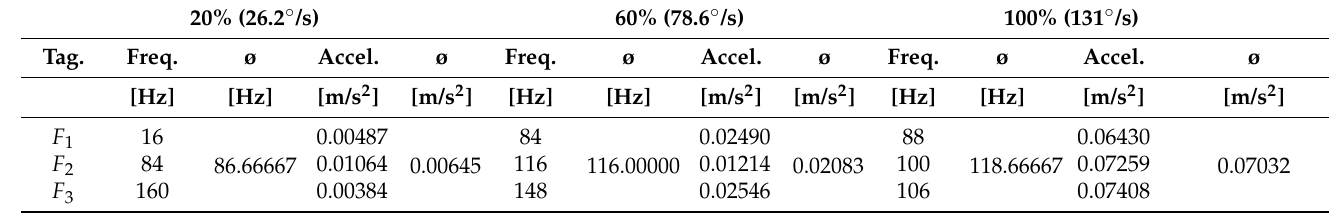
Table 7. Evaluated measured values of frequency and acceleration in Y -axis for each velocity.